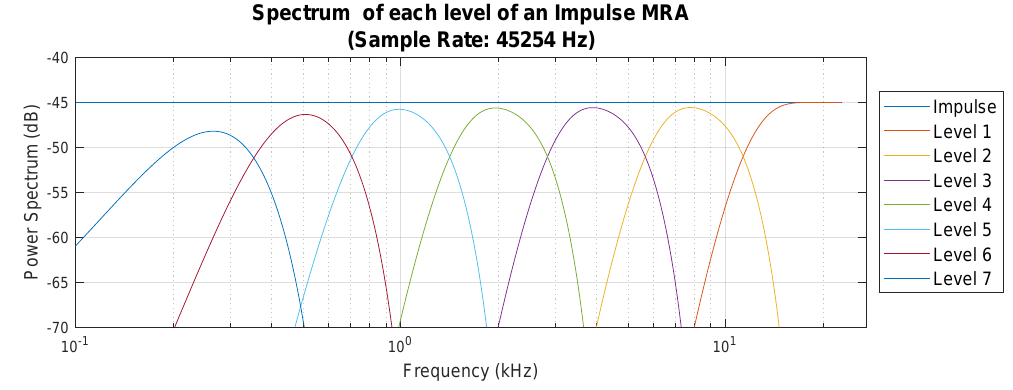
Figure 6. Frequency content of impulse MRA levels 1–7, representing octave bands